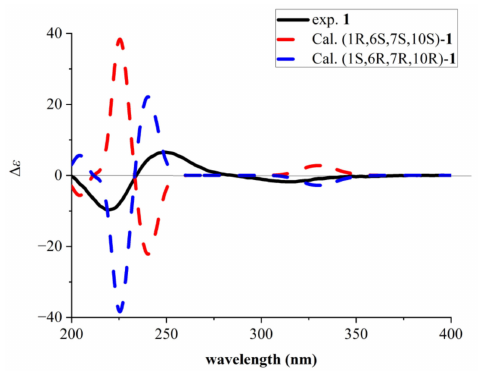
Figure 5. Calculated and experimental ECD spectra of 1